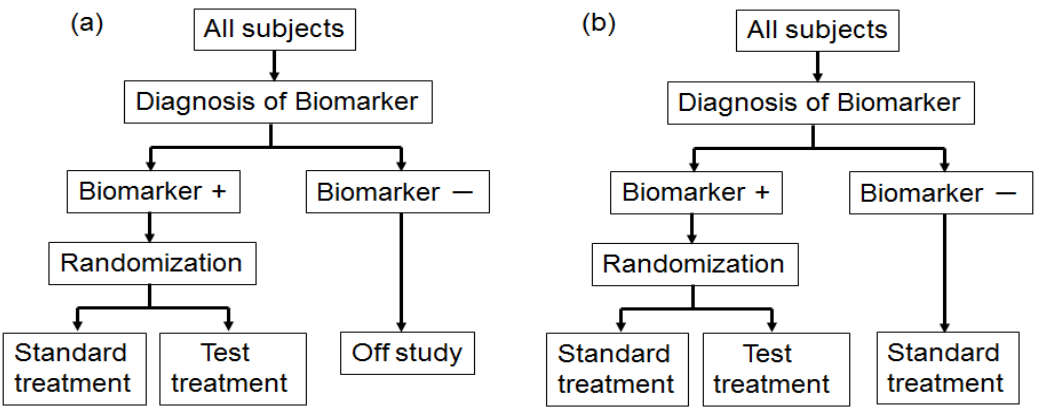
Figure 4. ( a ) Enrichment study design and ( b ) hybrid design. ‘+’ and ‘–’ correspond to the respective positive and negative biomarker